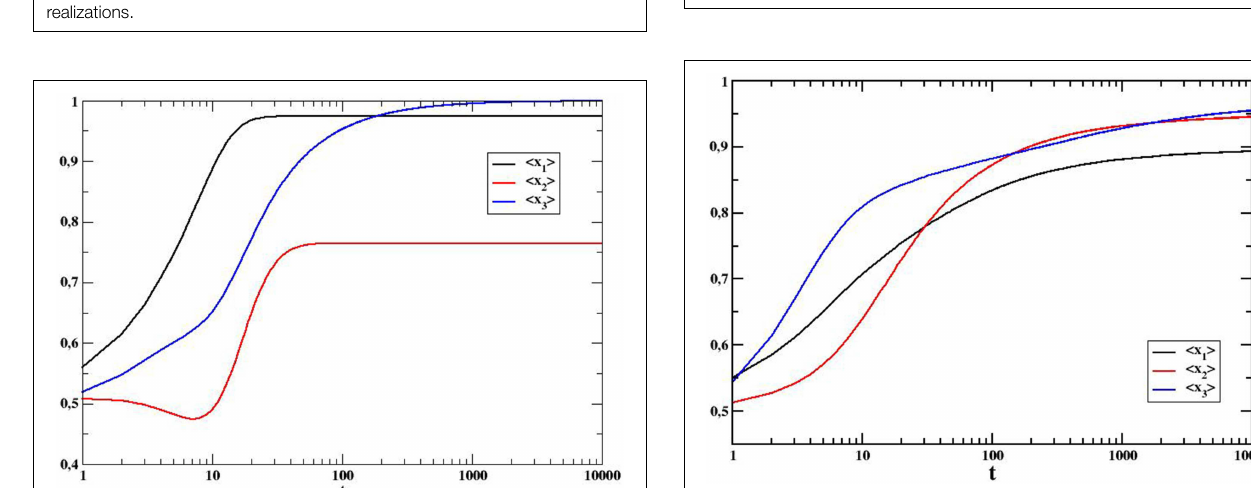
FIGURE 3 | Average opinion as a function of time for a system of N = 100 on a one-dimensional ring for three different initial conditions. Averages over 2000 independent realizations.